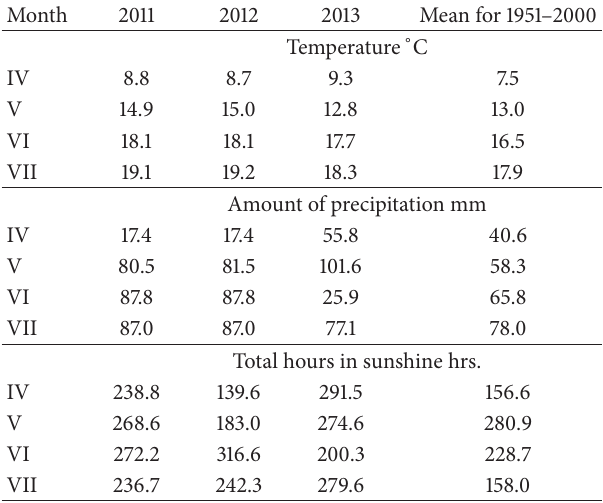
Table 1: Mean monthly air temperatures, amount, and total hours of precipitation at ES Felin in the years